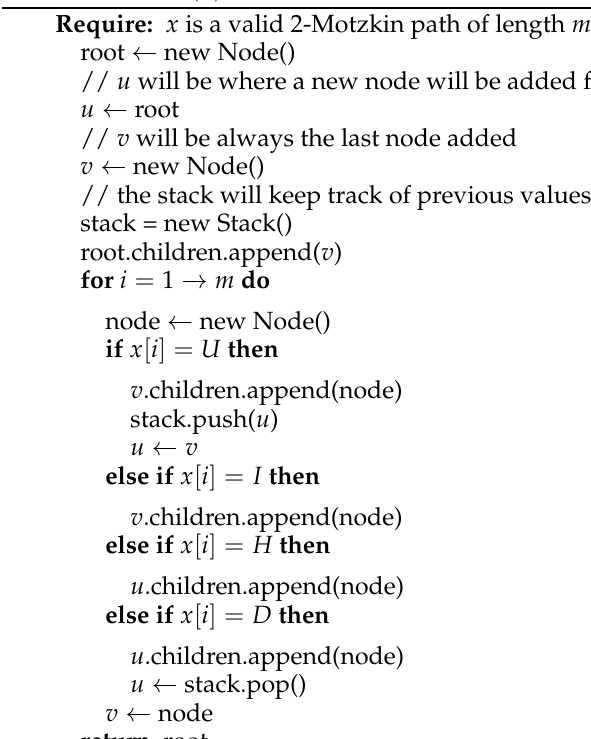
Algorithm 2: Algorithm to convert a sampled 2-Motzkin path to a plan tree. The pseudocode calculates Φ − 1 ( x )